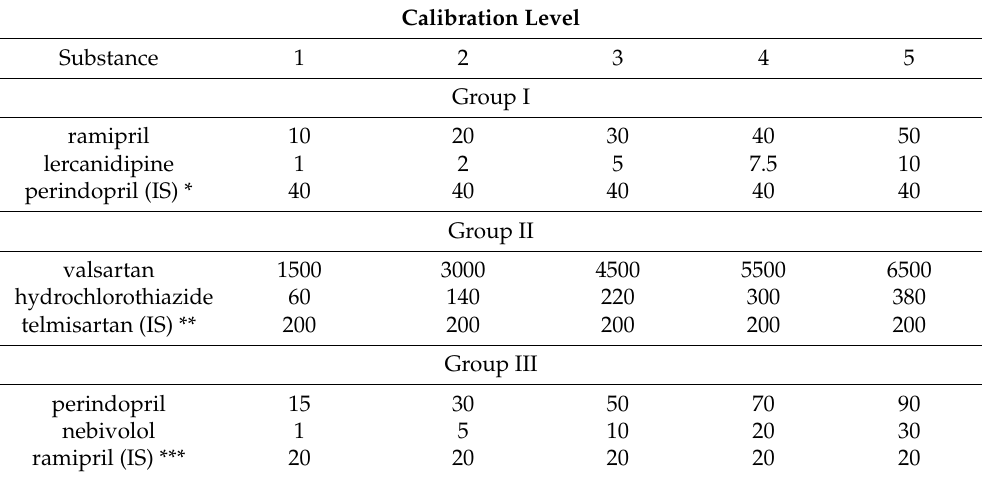
Table 6. Calibration curve concentrations of individual antihypertensive drugs and IS in the human plasma